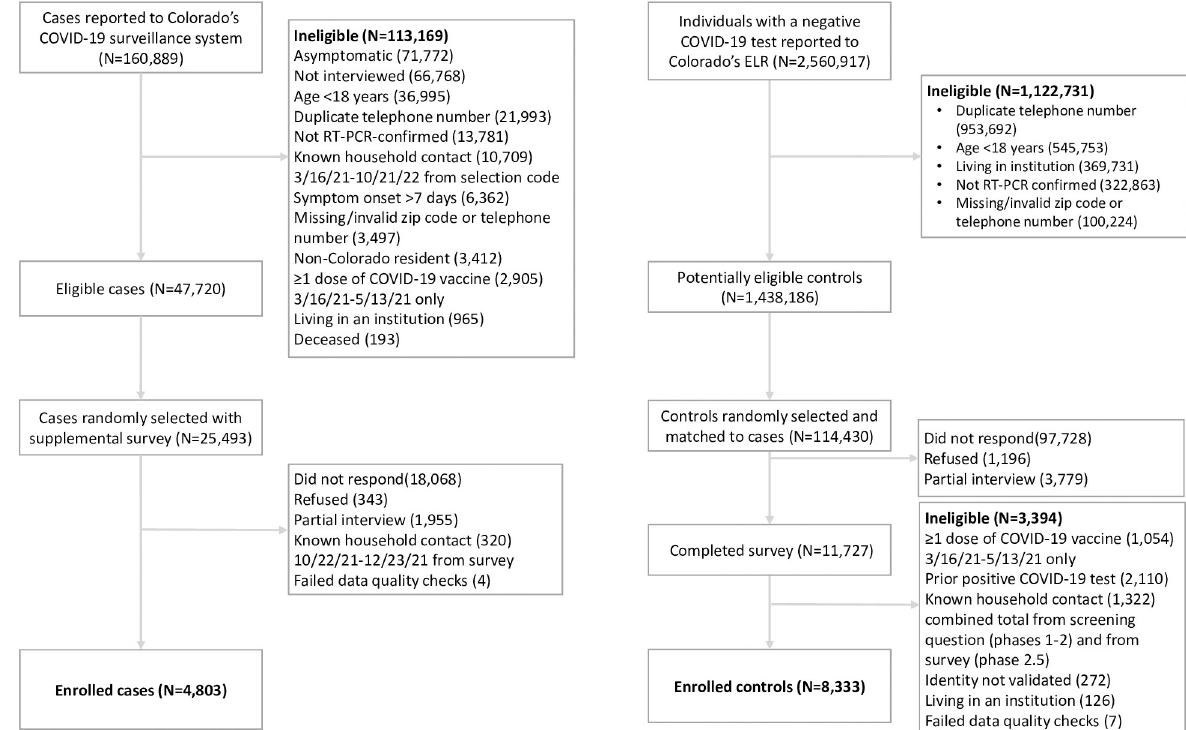
Fig 1. Eligibility and enrollment cases (persons with positive SARS-CoV-2 test results) and controls (persons with negative SARS-CoV-2 test results) among Colorado adults aged � 18 years–specimen collection dates from March 16 to Deceber 23, 2021.